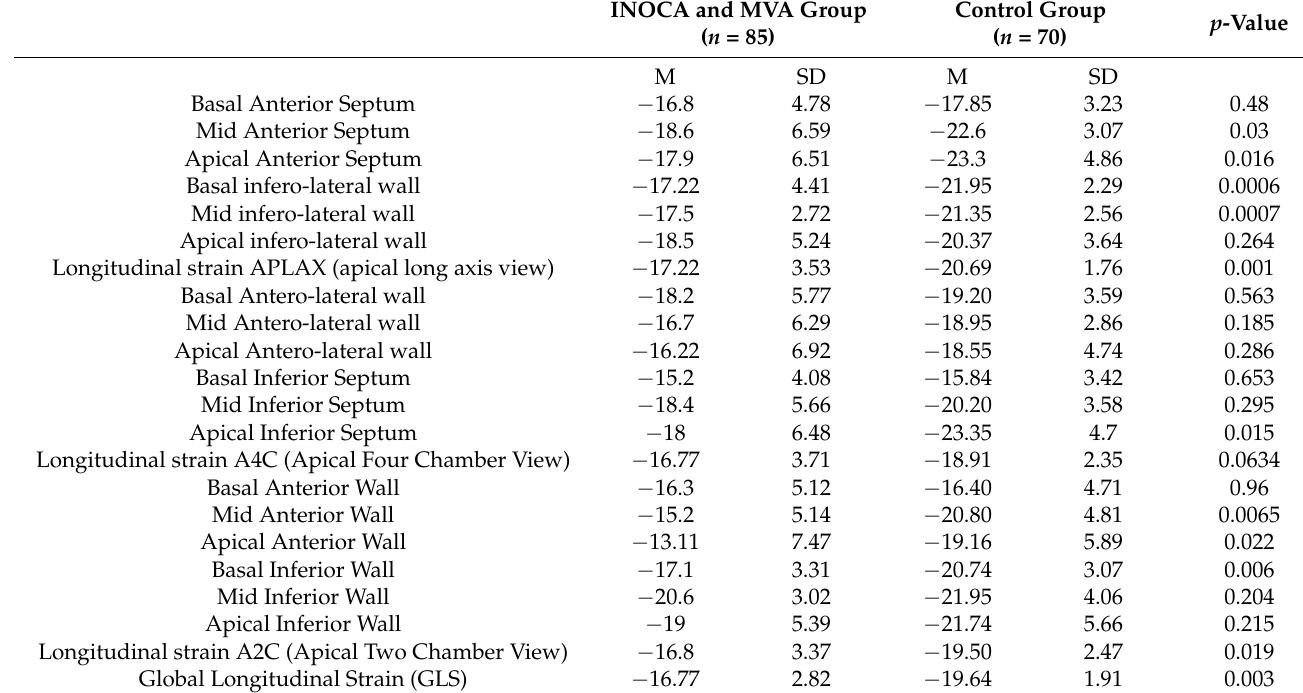
Table 2. Comparison of longitudinal strain in patients with INOCA and microvascular angina (AM) and control